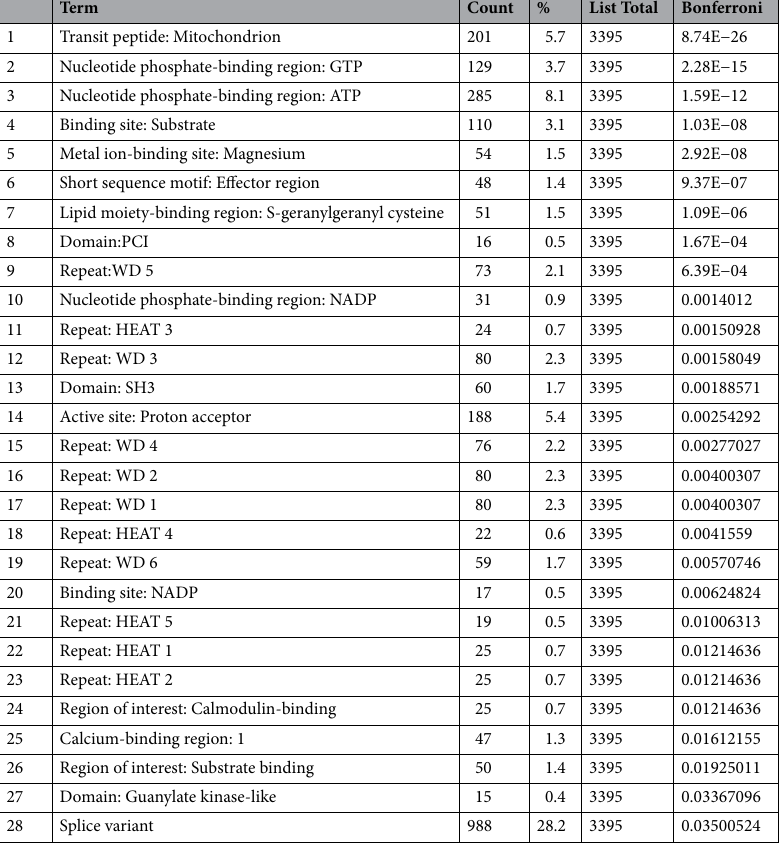
Table 1. The sequence features of S2 proteins analyzed by DAVID.